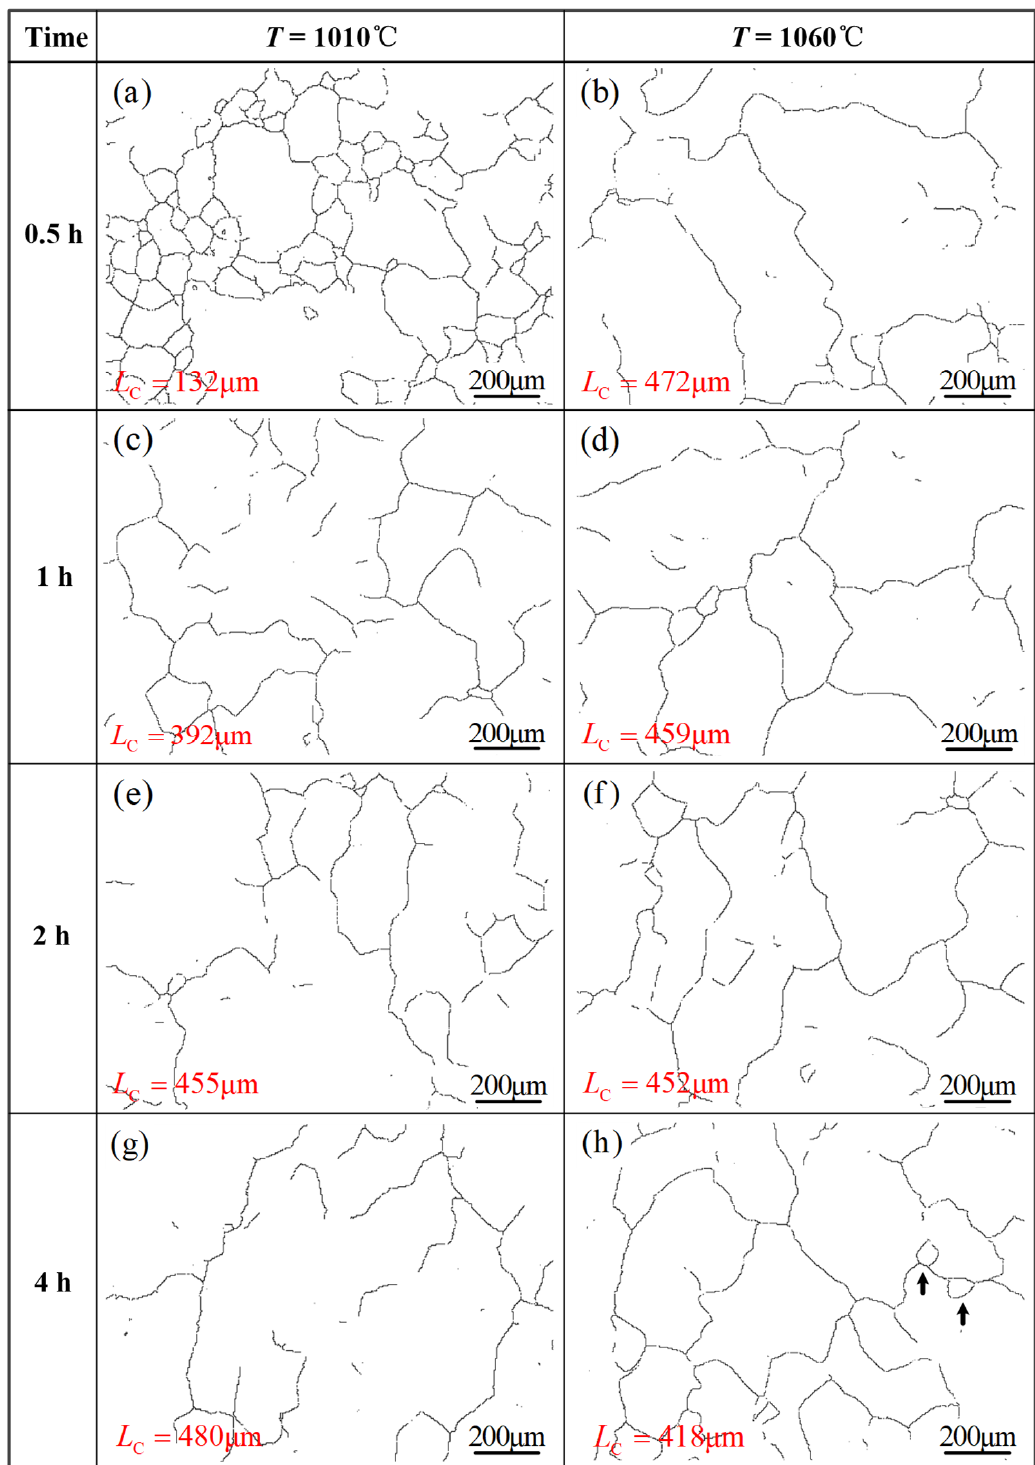
Figure 3. Random GB maps of specimens annealed at 1010 °C and 1060 °C for different time based on the initial plate after hot-rolling at 800 °C with 5% reduction. ( a , c ,e, g ) 1010 °C vs. 0.5 h, 1 h, 2 h, 4 h; ( b , d , f , h ) 1060 °C vs. 0.5 h, 1 h, 2 h, 4 h.